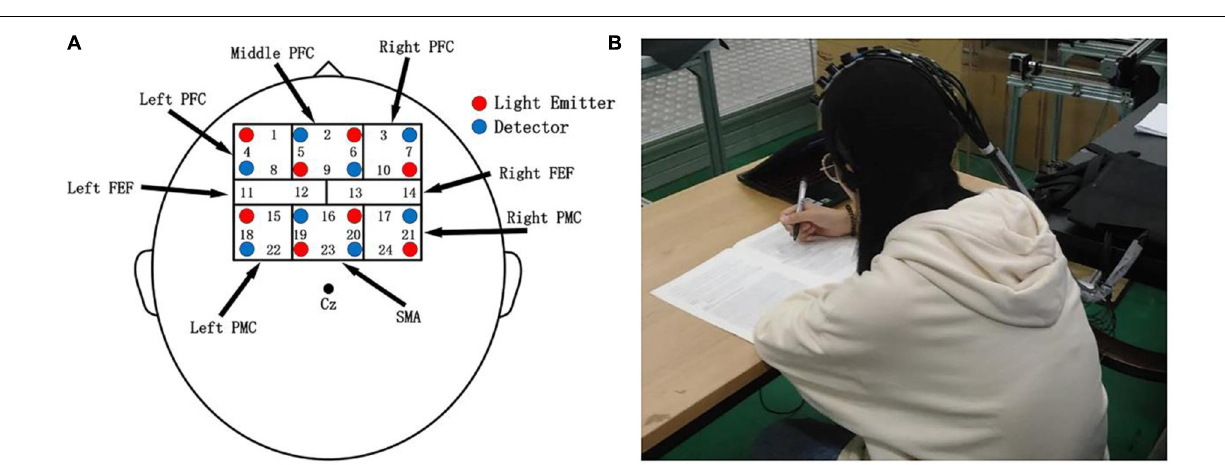
FIGURE 3 | (A) Probe and functional brain region distribution map; red and blue numbers represent sources and detectors, respectively. (B) Experimental